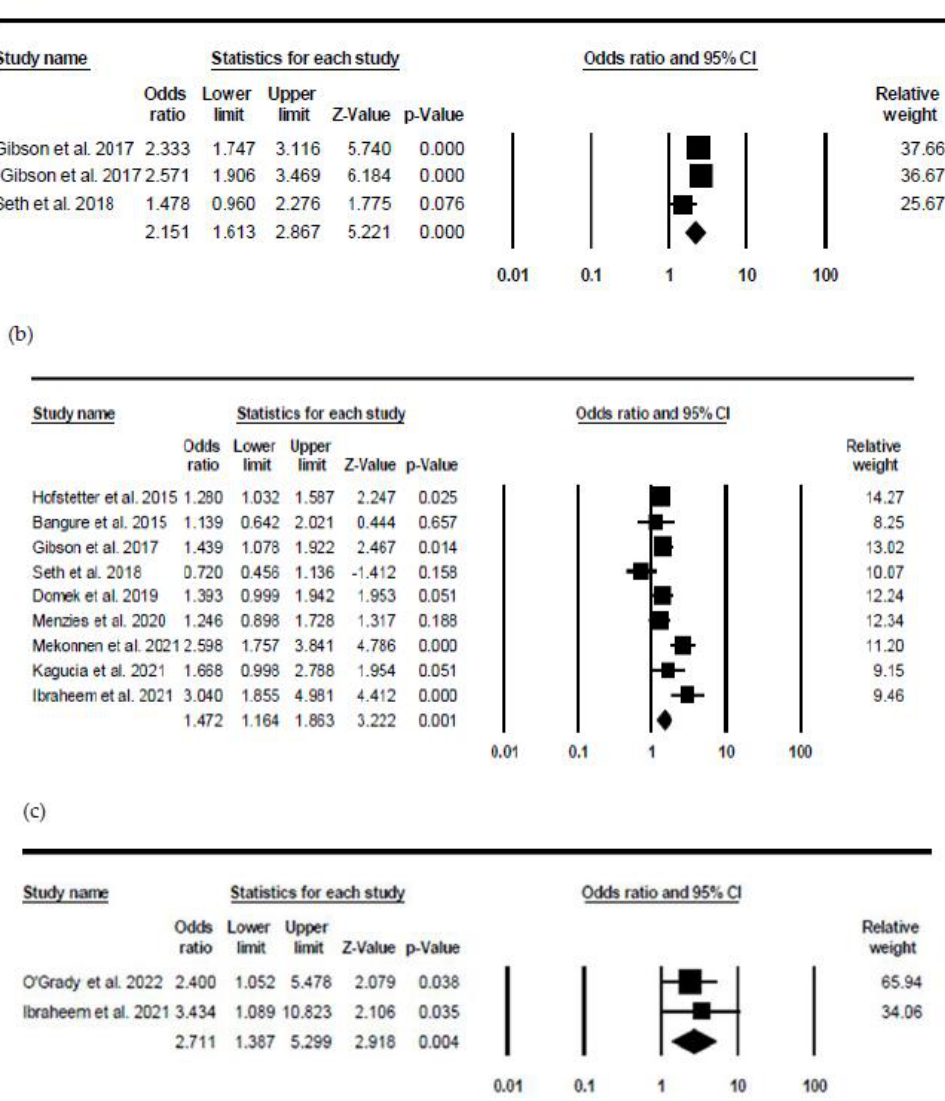
Figure 2. Forest plot of interventions on immunisation coverage. ( a ) SMS reminder and incentive on coverage: Heterogeneity: Q-value = 2.051, p -value = 0.562, I-square 0.000. [31,32,36]. ( b ) Reminder SMS on coverage. Heterogeneity: Q = 35.13, p = 0.001, I-square = 74.381.[9,26,29,31 – 34,39,43,44]. ( c ) Voice call on coverage. Heterogeneity: Q-value = 47.973, p -value = 0.001, I-square 93.746 [15,30,32,42]. ( d ) SMS health education. Heterogeneity: Q-value = 5.705, p -value = 0.017, I-square 82.472.[13,44]. ( e ) Voice call and SMS on coverage. Heterogeneity: Q = 3.265, df = 1, p = 0.071, I2 = 69.37. [40,41].